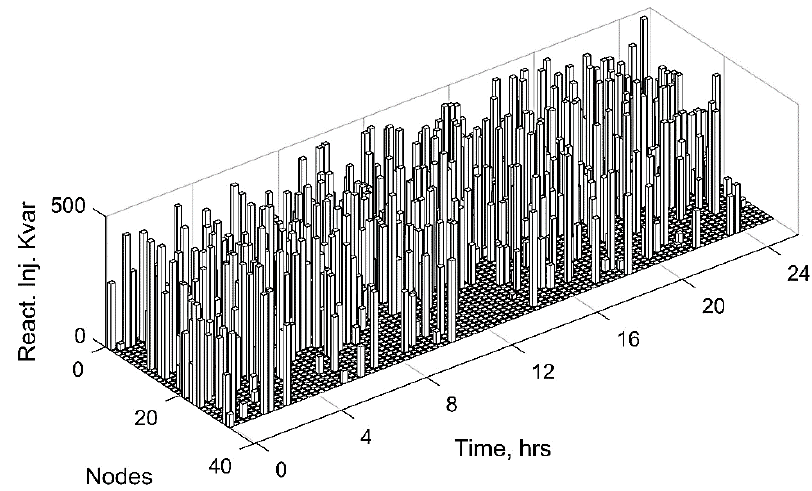
Figure 8. Reactive power injection node locations and magnitude .